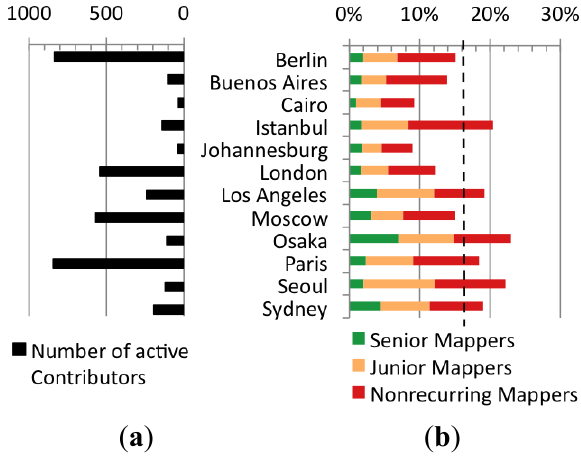
Figure 4. (a) Number of active contributors; and (b) Percentage of mapper group contributions per urban area (Aug.–Oct.